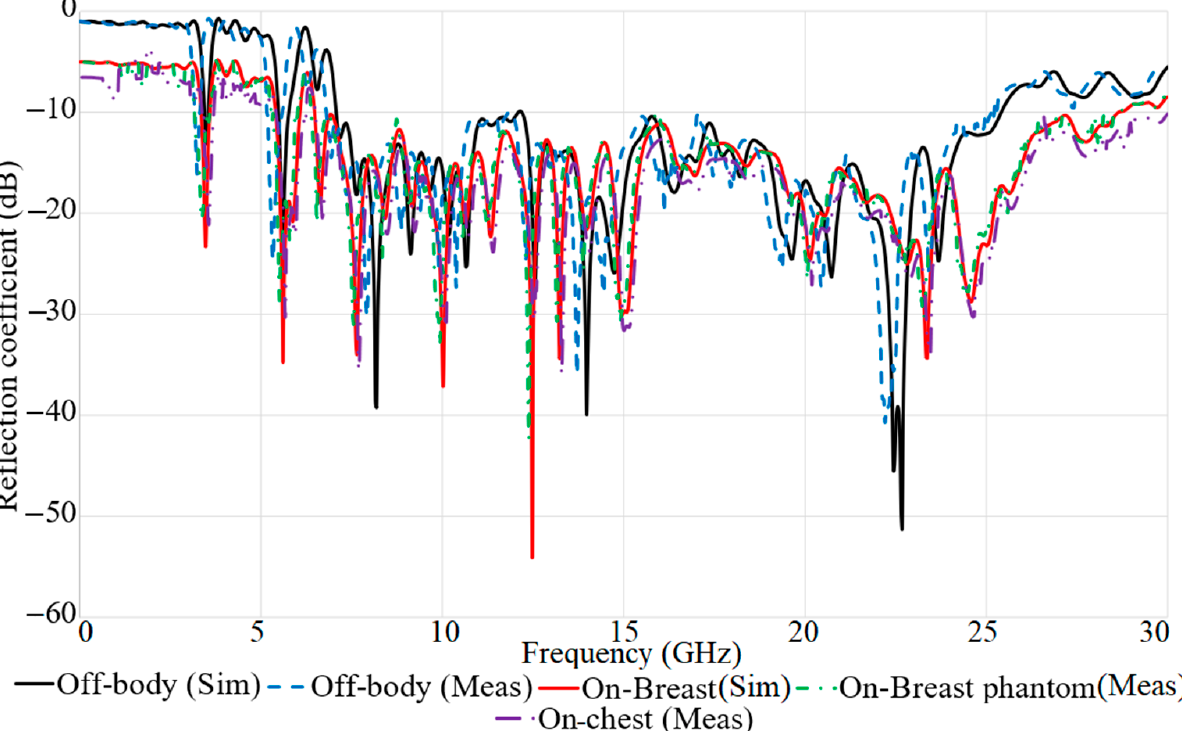
Figure 4. The reflection coefficient result of the proposed antenna on-body (on breast) and off-body for simulation (sim) and measurement (meas).